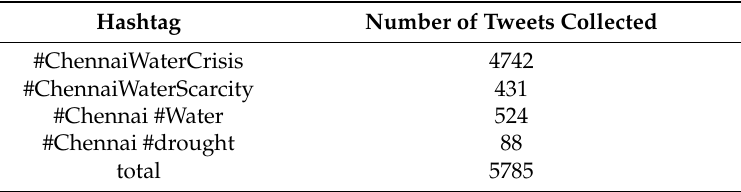
Table 1. Number of tweets collected under each key hashtag.